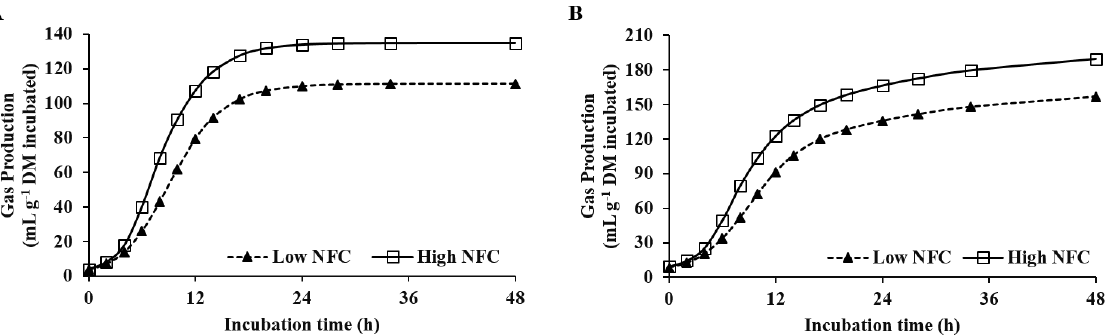
Figure 3. Interaction of “diet × time” for the average gas production of nonfiber carbohydrates ( A ) ( p < 0.0001) and total carbohydrates ( B ) ( p < 0.0001).